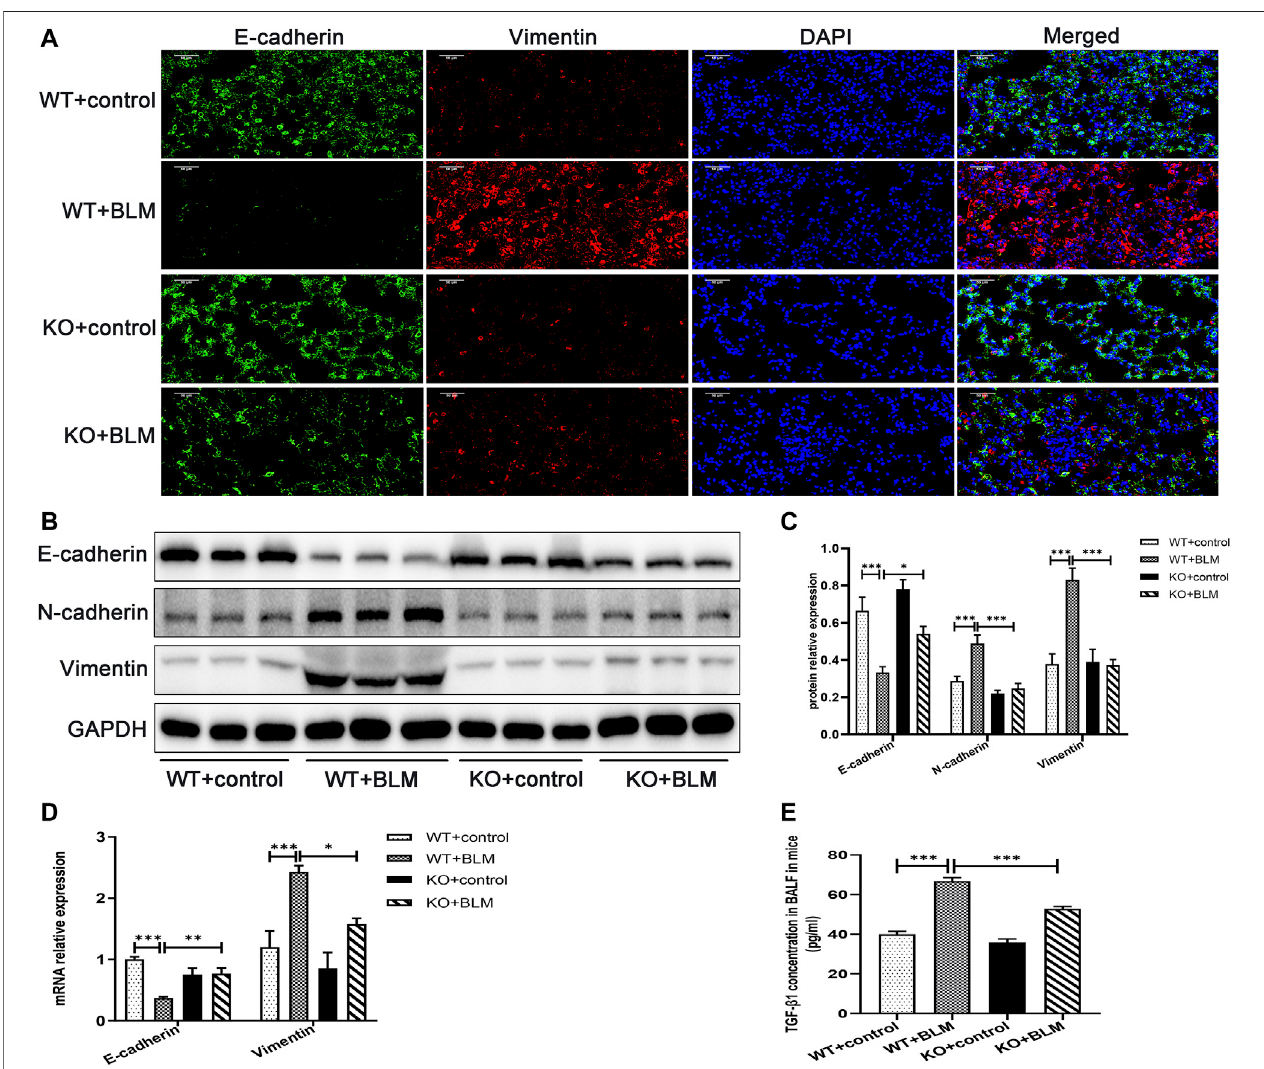
FIGURE 3 | Dec1 KO inhibits EMT in the BLM-induced PF murine model. WT and KO mice were treated with a single intratracheal injection of BLM (2.5 mg/kg) or salinefor21 days. (A) Dualimmuno fl uorescentanalysisforE-cadherinandVimentinexpressioninthelungstissueofmice.Scalebar=50 μ m. (B) Theproteinexpression of E-cadherin, N-cadherin and Vimentin in the lung tissues of mice were measured by western blotting. (C) Statistical analysis of relative expression levels of proteins in (B) . (D) ThemRNAexpressionof E-cadherin and Vimentin inthelungtissuesofmicewereassessedbyqRT-PCR. (E) TGF- β 1levelsinBALFofmice. n =6.Dataare shown as the mean ± SEM. Statistical analysis was performed by one-way ANOVA. * p < 0.05, ** p < 0.01, *** p < 0.001, ns p > 0.05.